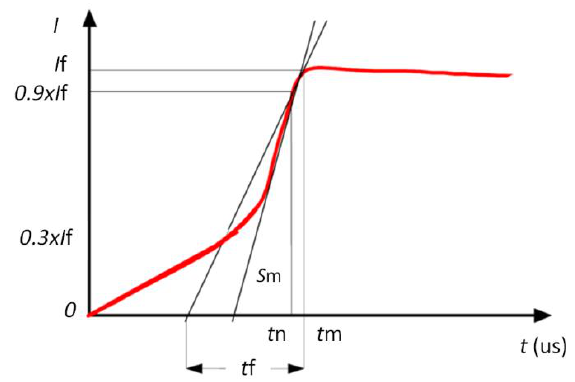
Figure 2. International Council on Large Electric Systems (CIGRE) concave shape of the lightning current waveform.